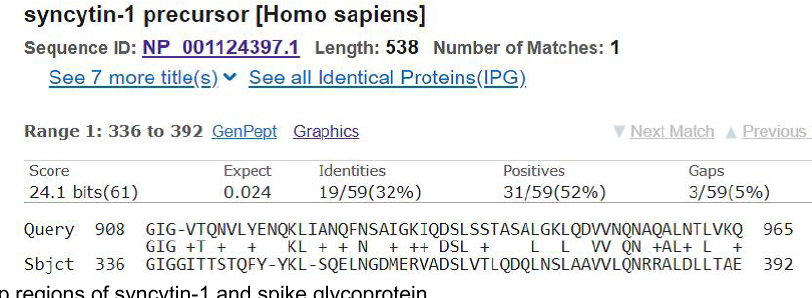
Figure 2. Overlap regions of syncytin-1 and spike glycoprotein